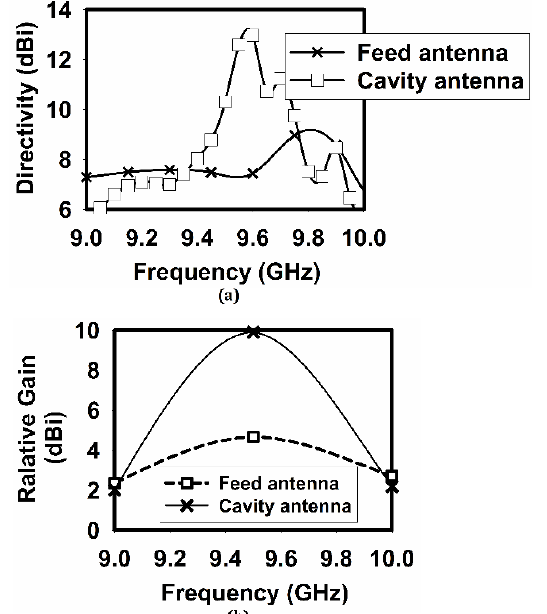
Figure.9. (a) Simulated directivity (b) Measured antenna gain